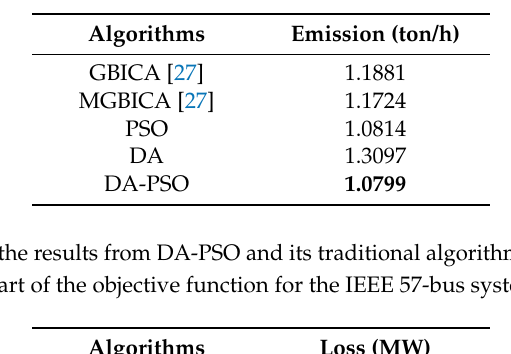
Table 7. Comparison of the results from DA-PSO and other algorithms when considering the only emissions as part of the objective function for the IEEE 57-bus system.